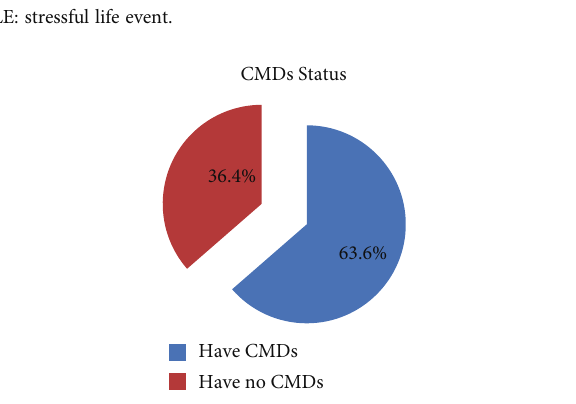
Figure 2: Prevalence of common mental disorders among prisoners in North Wollo zone correctional institutions, Northeastern Ethiopia. Figure